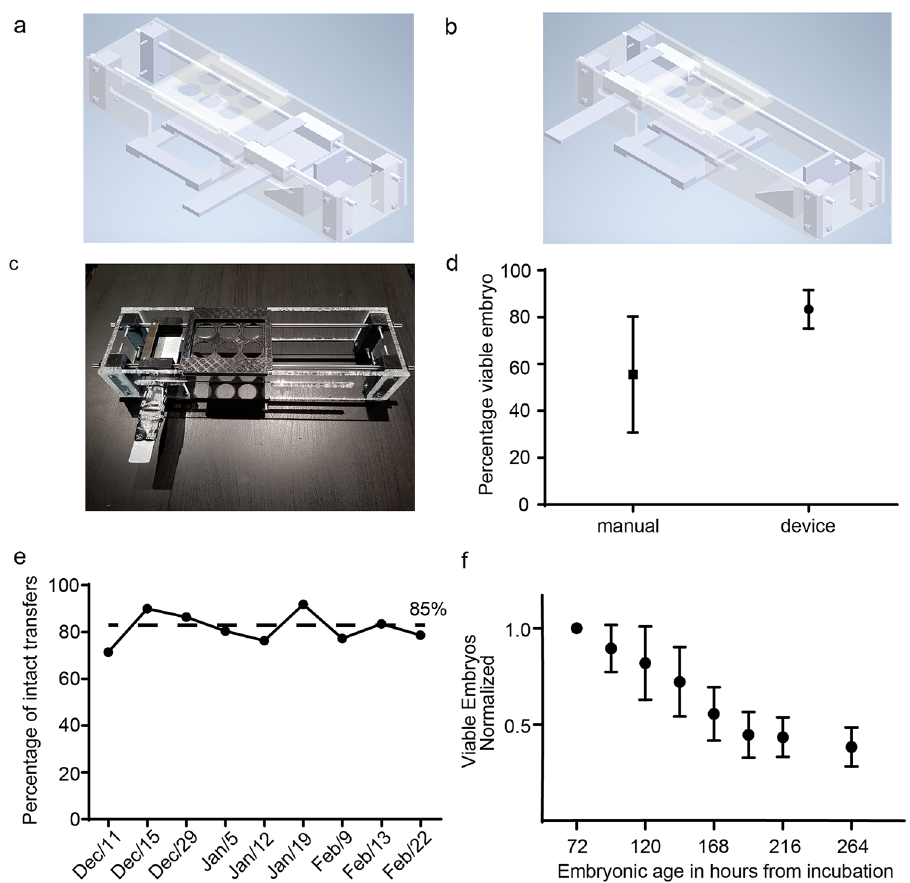
Figure 2. Embryo Transfer to multi-well plates. ( a , b ) CAD drawing of the quail egg opener in the before and after positions for opening quail eggs. ( c ) The blade collision device to open the quail eggs and transfer them to the six-well plate. ( d ) The quail batches used for the device method varied between 40 and 75 quail eggs per batch with 8 batches done. Three batches were used for the manual forceps method had between 32 and 75 quail eggs each with 3 batches done, error bars are standard deviation. ( e ) Number of viable egg yolks transferred to six-well plates weekly over a period of 9 weeks. ( f ) The age vs survival of the quail embryos used to choose the experiment start date error bars are standard